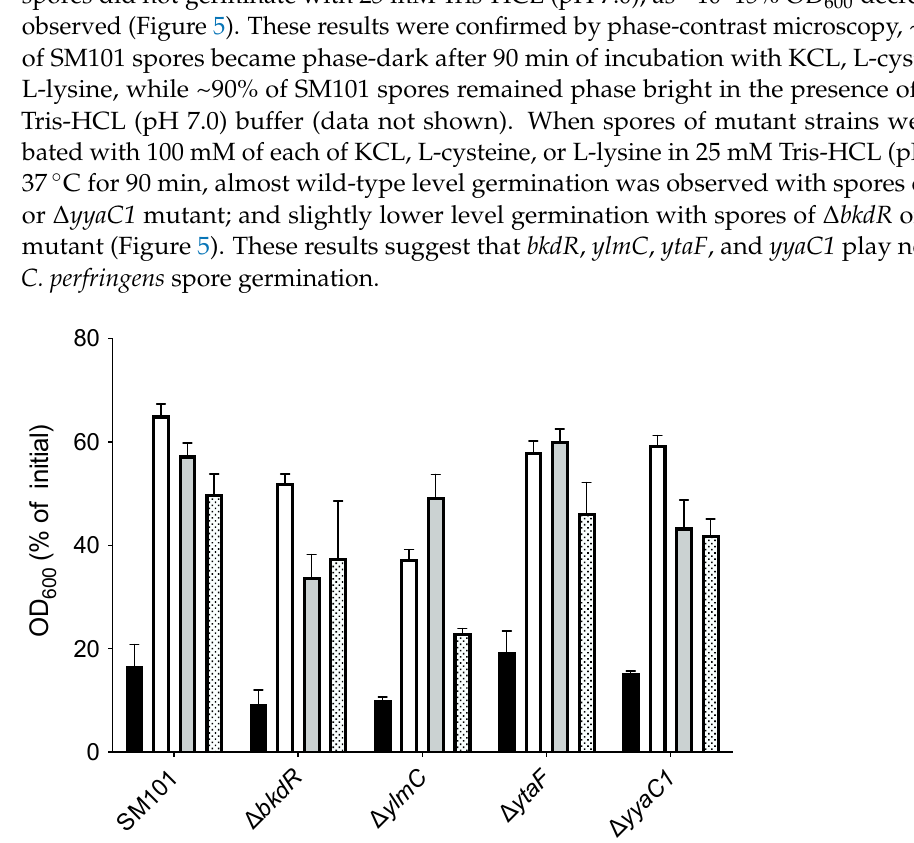
Figure 5. Germination of C. perfringens spores with various germinants. Heat-activated spores of C. perfringens wild-type strain SM101 and its mutant derivatives were germinated with 25 mM Tris-HCl (pH 7.0) (buffer control) (black bar); 100 mM KCl in 25 mM Tris-HCl (pH 7.0) (white bar); 100 mM L-cysteine in 25 mM Tris-HCl (pH 7.0) (grey bar); and 100 mM L-lysine in 25 mM Tris-HCl (pH 7.0) (dotted bar) at 37 ◦ C for 90 min, and the OD 600 was measured as described in Material and Methods. The data represents the means of three separate experiments and the standard errors of the mean were less than 25% of the mean.